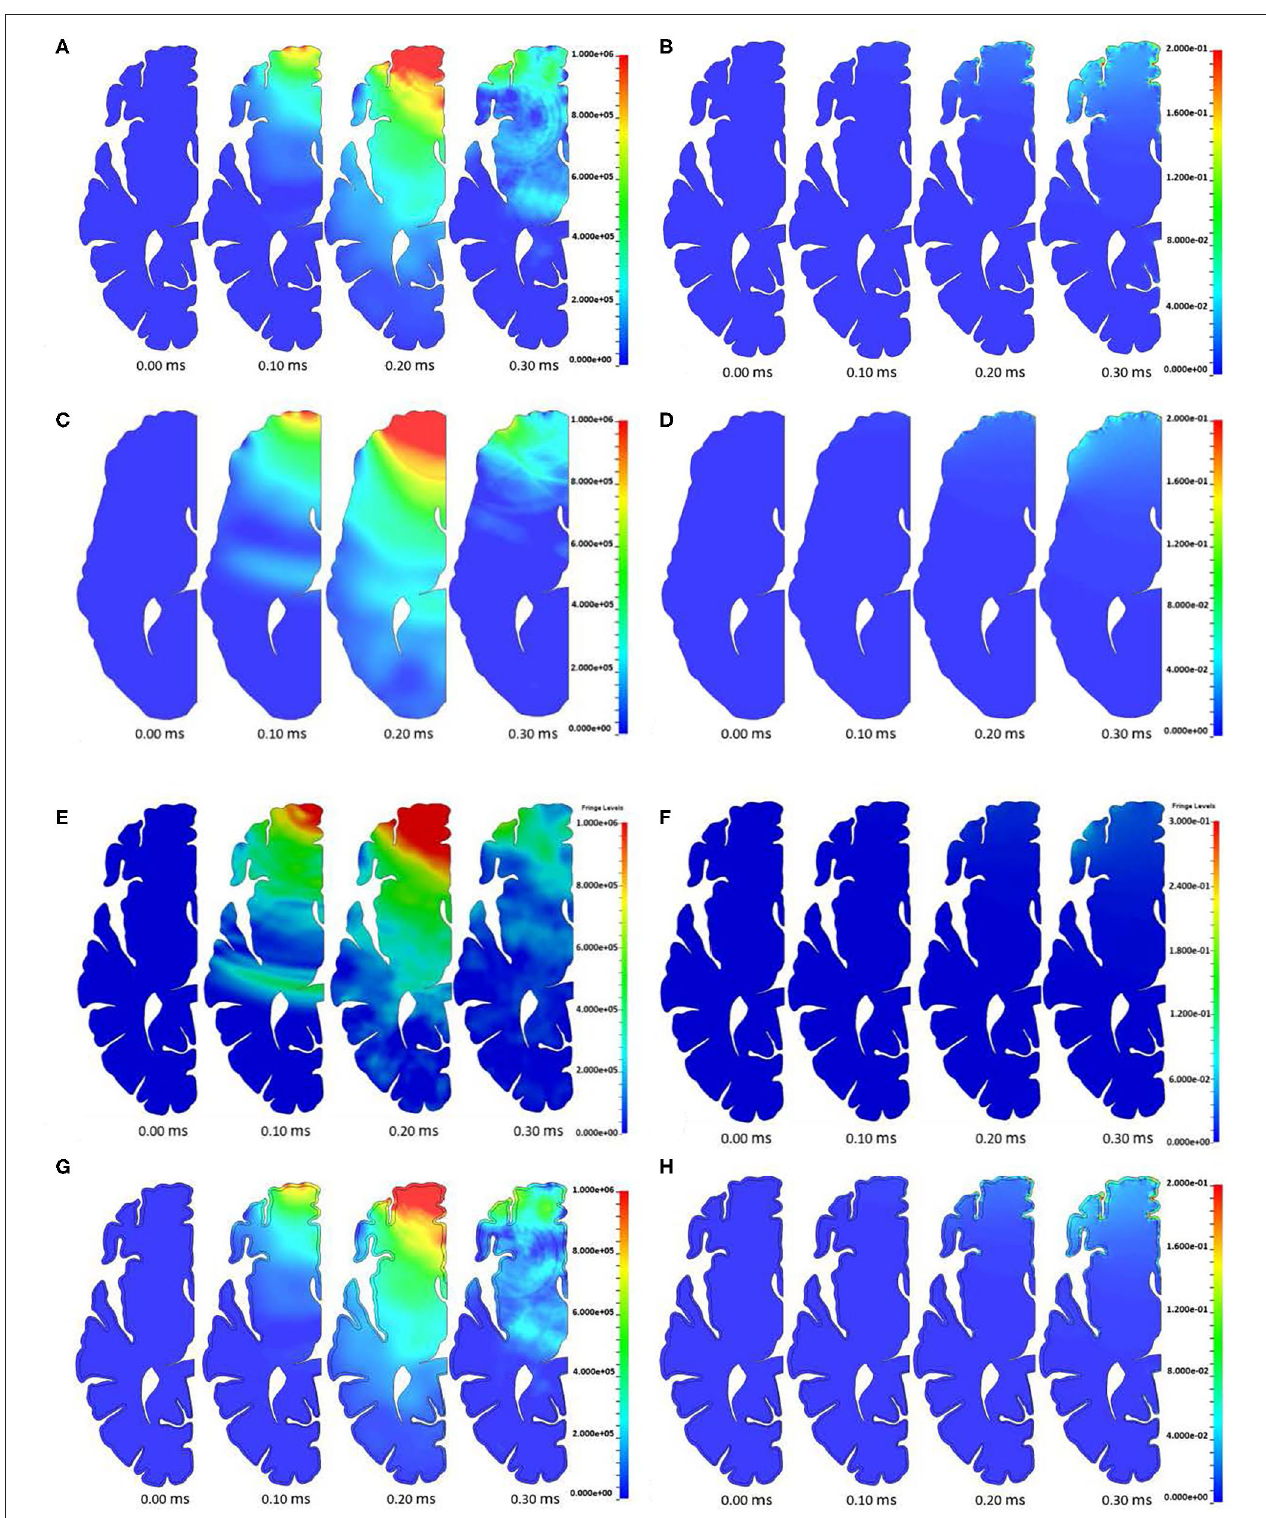
FIGURE 7 | (A) Pressure and (B) shear strain evolution in the model with a homogeneous brain model. (C) Pressure and (D) shear strain evolution in the smooth brain model. (E) Pressure and (F) shear strain evolution in the Lagrangian CSF model. (G) Pressure and (H) shear strain evolution in the model with a differentiated brain model. From left to right in each grouping: 0, 0.10, 0.20, and 0.30ms.